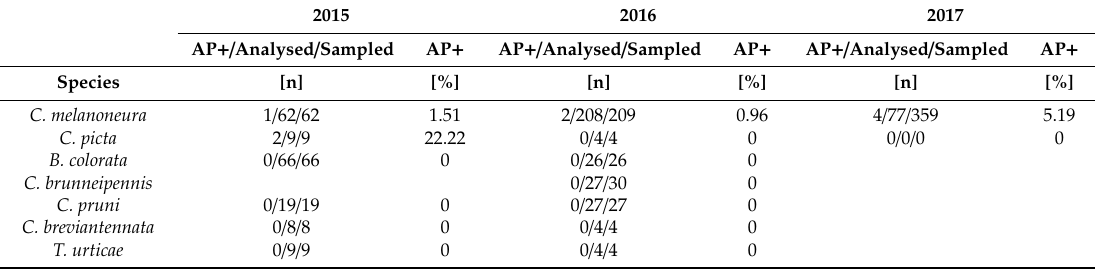
Table 2. Infection rates for ‘ Ca. P. mali’ in the most abundant psyllid species in the studied apple orchard in 2015–2017; apple proliferation (AP) + = ‘ Ca . P. mali’ positive, n = number of